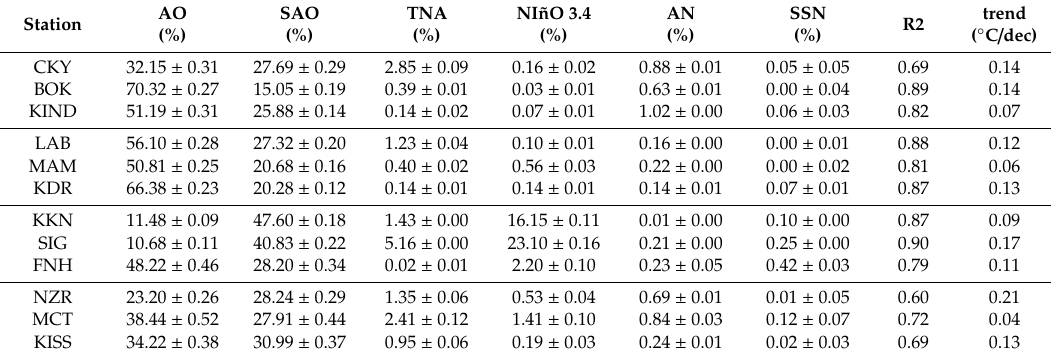
Table 2. The corresponding values of geographical coordinates for the 12 weather stations. The coe ffi cient of determination (R 2 ). Contribution and corresponding standard deviation (in percentages) of Annual Oscillation (AO), Semi Annual Oscillation (SAO), Tropical Northern Atlantic (TNA), El Niño 3.4 (Niño3.4), Sun Spot Number (SSN) and Atlantic Niño (AN) and